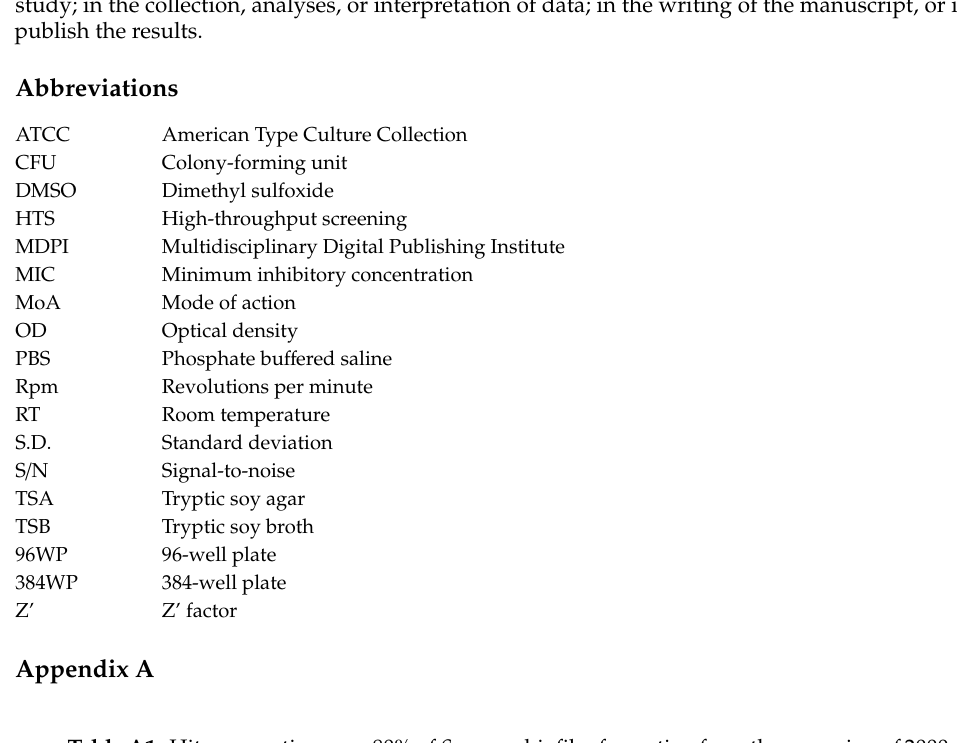
s1. Table S1: Compounds identification and inhibition results of the pilot screening performed on S. aureus biofilms in 96WP and 384WP. Table S2: Identification of the compounds from the Microsource Spectrum Collection (Discovery Systems Inc., Houston, TX, USA) and results of the screening performed on S. aureus planktonic cells and biofilms in 384WP. Figure S1: Correlation of the Z’ factor and the signal-to-noise (S / N) statistical parameters throughout the optimization process. Figure S2: Folds of the Z’ factor and the Max-Min value obtained for the crystal violet assay after di ff erent incubation periods of the dye in the wells and di ff erent dissolution periods in ethanol.